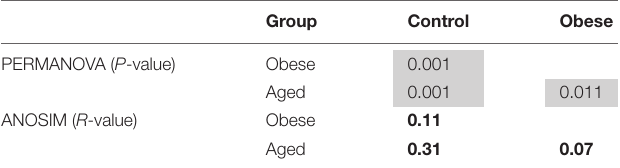
TABLE 5 | Summary of ANOSIM and PERMANOVA outputs.